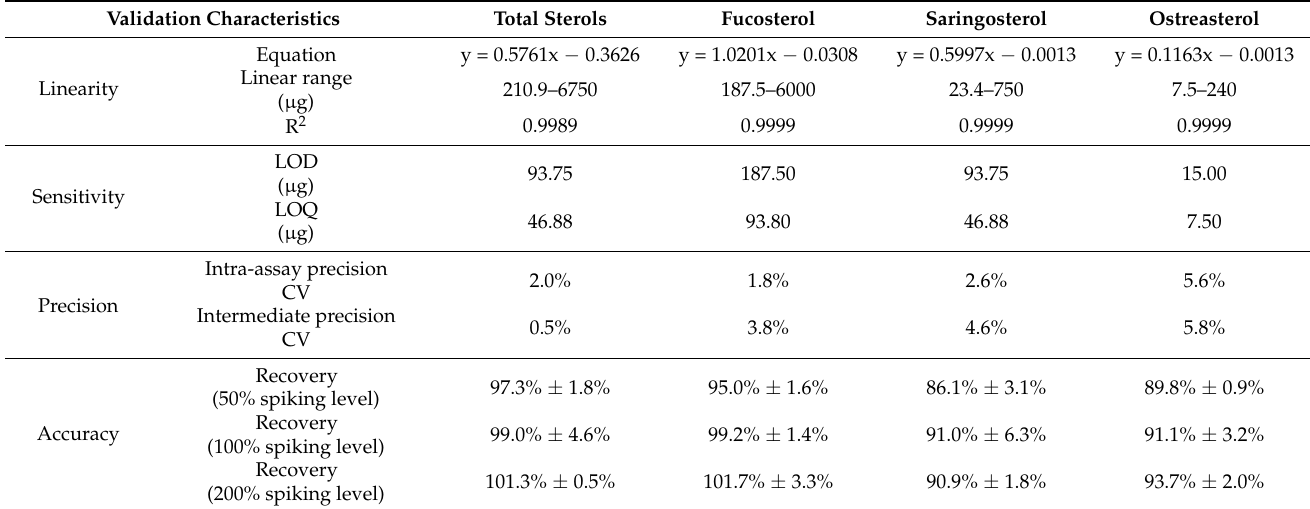
Table 3. Linearity, sensitivity, precision, and accuracy of the phytosterol analytes.